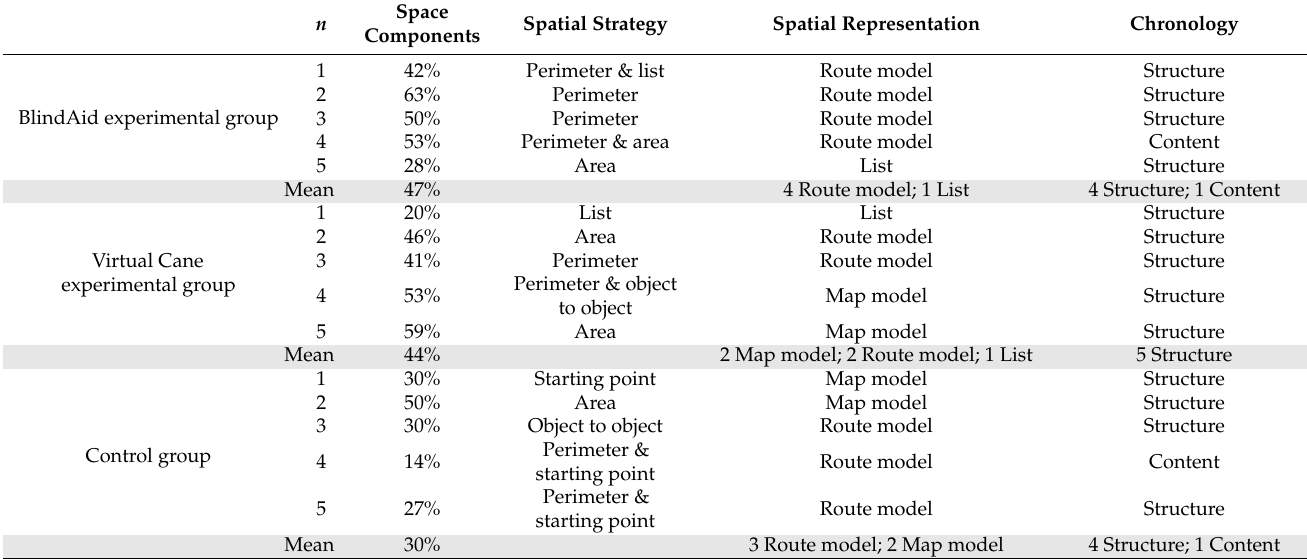
Table 5. Verbal description process of complex